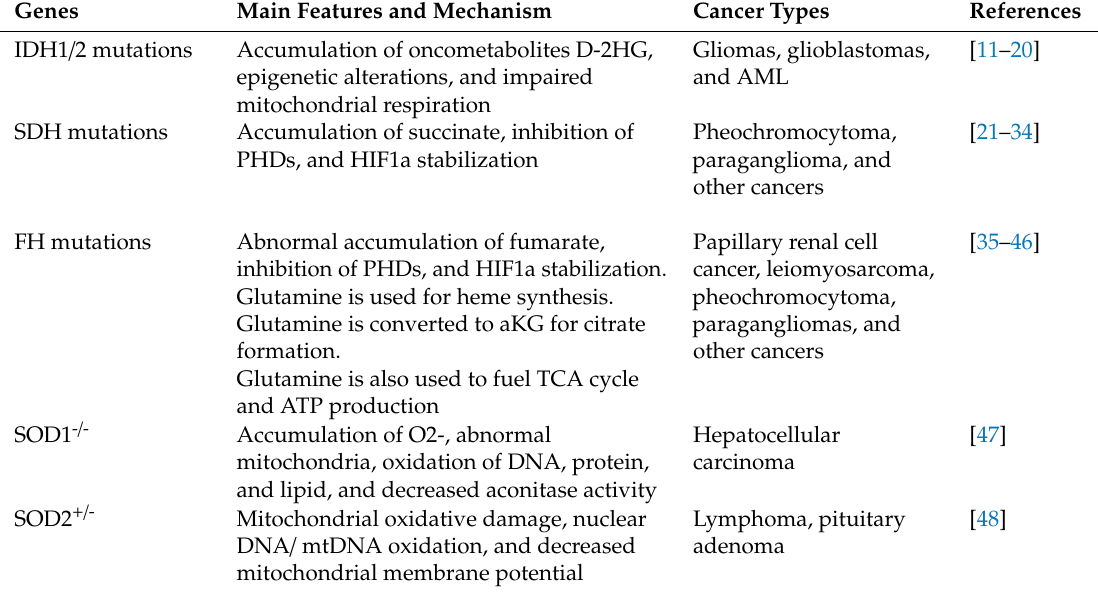
Table 1. Examples of mitochondrial enzyme dysfunction in cancer